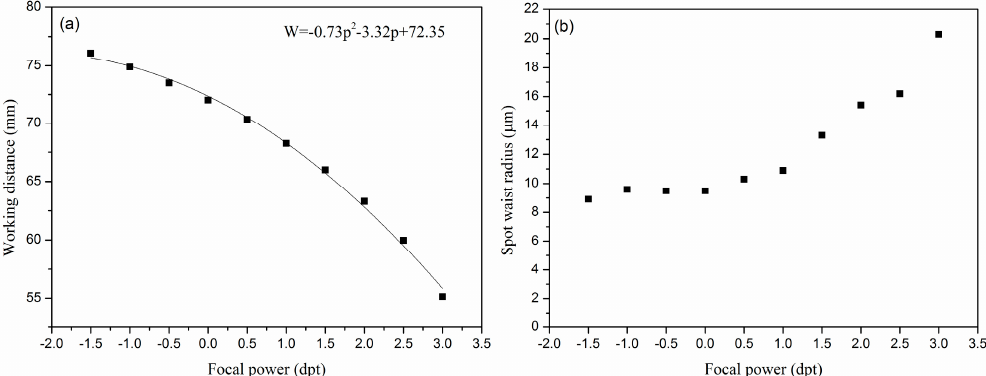
Figure 4. ( a ) Measured working distance as a function of focal power of the tunable lens. The zero focal power corresponds to an infinite focal length for the tunable lens. In this case, the focus of the lens combination is at the working distance of the f-theta lens alone; ( b ) Measured waist radius at the focal point of the lens combination as a function of the focal power of the tunable lens.